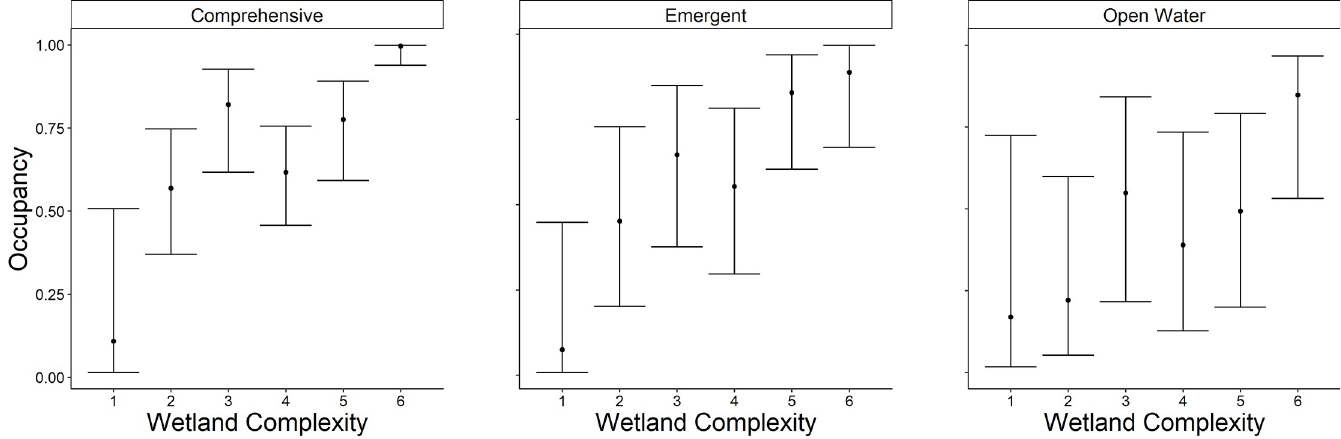
Fig 4. Predicted probability (95% confidence limits) of site occupancy across wetland complexity levels in Illinois during late spring and early summer 2015– 2017. Site type (National Wetland Inventory) was held constant. Each box represents one grouping of species, labeled at the top, with comprehensive being all the species in open water and emergent